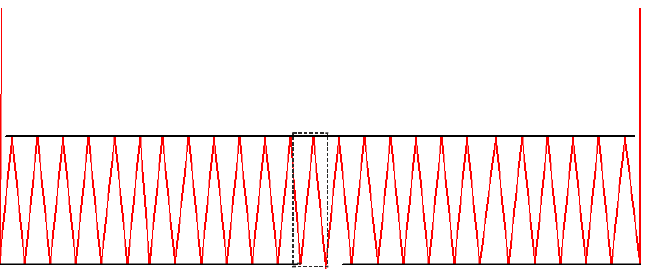
Figure 6. Focusing a tilted light wave that leads to a different number of reflections of the light